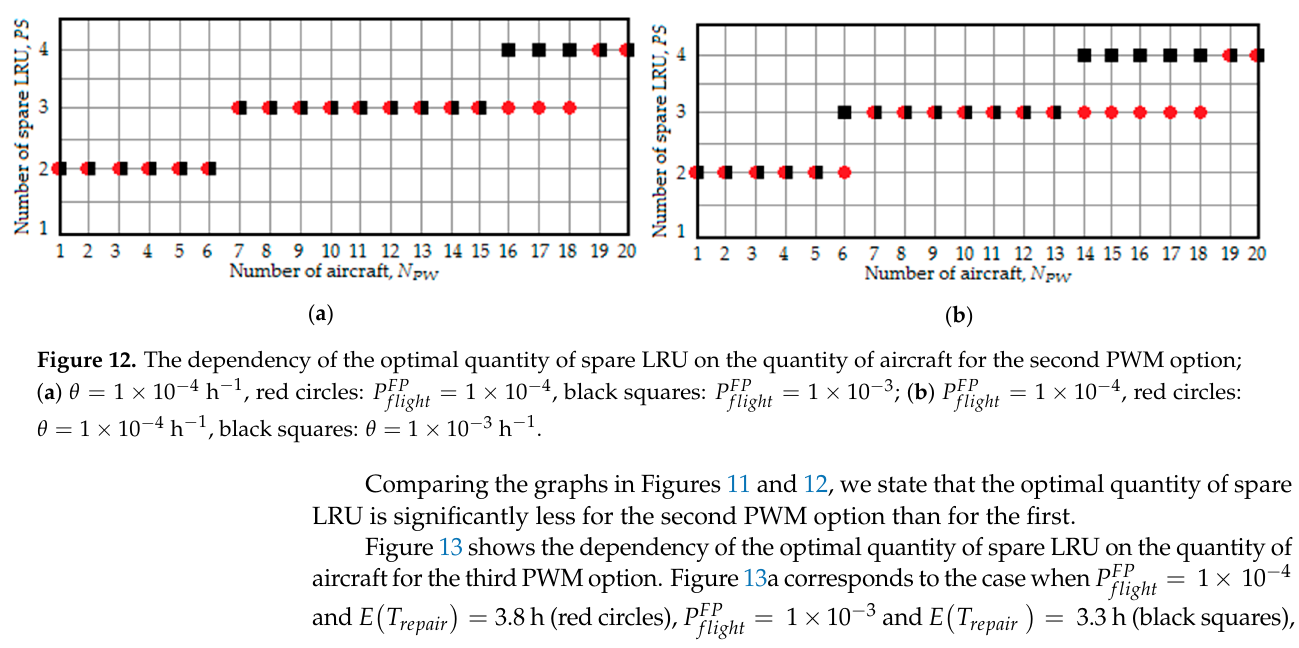
( a ) (black squares), and 𝜃 = 1 × 10 (cid:2879)(cid:2872) h (cid:2879)(cid:2869) . Figure 13b meets with 𝜃 = 1 × 10 (cid:2879)(cid:2872) h (cid:2879)(cid:2869) and ) = 3.8 h (red circles), 𝜃 = 1 × 10 (cid:2879)(cid:2871) h (cid:2879)(cid:2869) and 𝐸(𝑇 𝐸(𝑇 (cid:3045)(cid:3032)(cid:3043)(cid:3028)(cid:3036)(cid:3045) and 𝑃 (cid:3033)(cid:3039)(cid:3036)(cid:3034)(cid:3035)(cid:3047)(cid:3007)(cid:3017) = 1 × 10 (cid:2879)(cid:2872) .